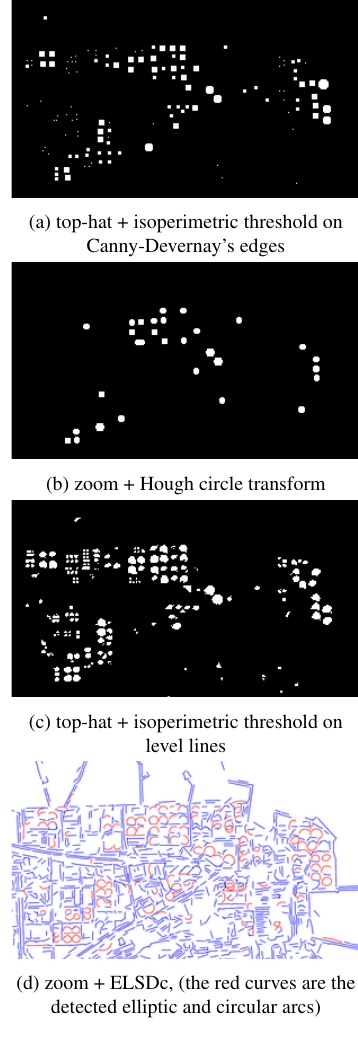
Figure 11. Detection result with the different